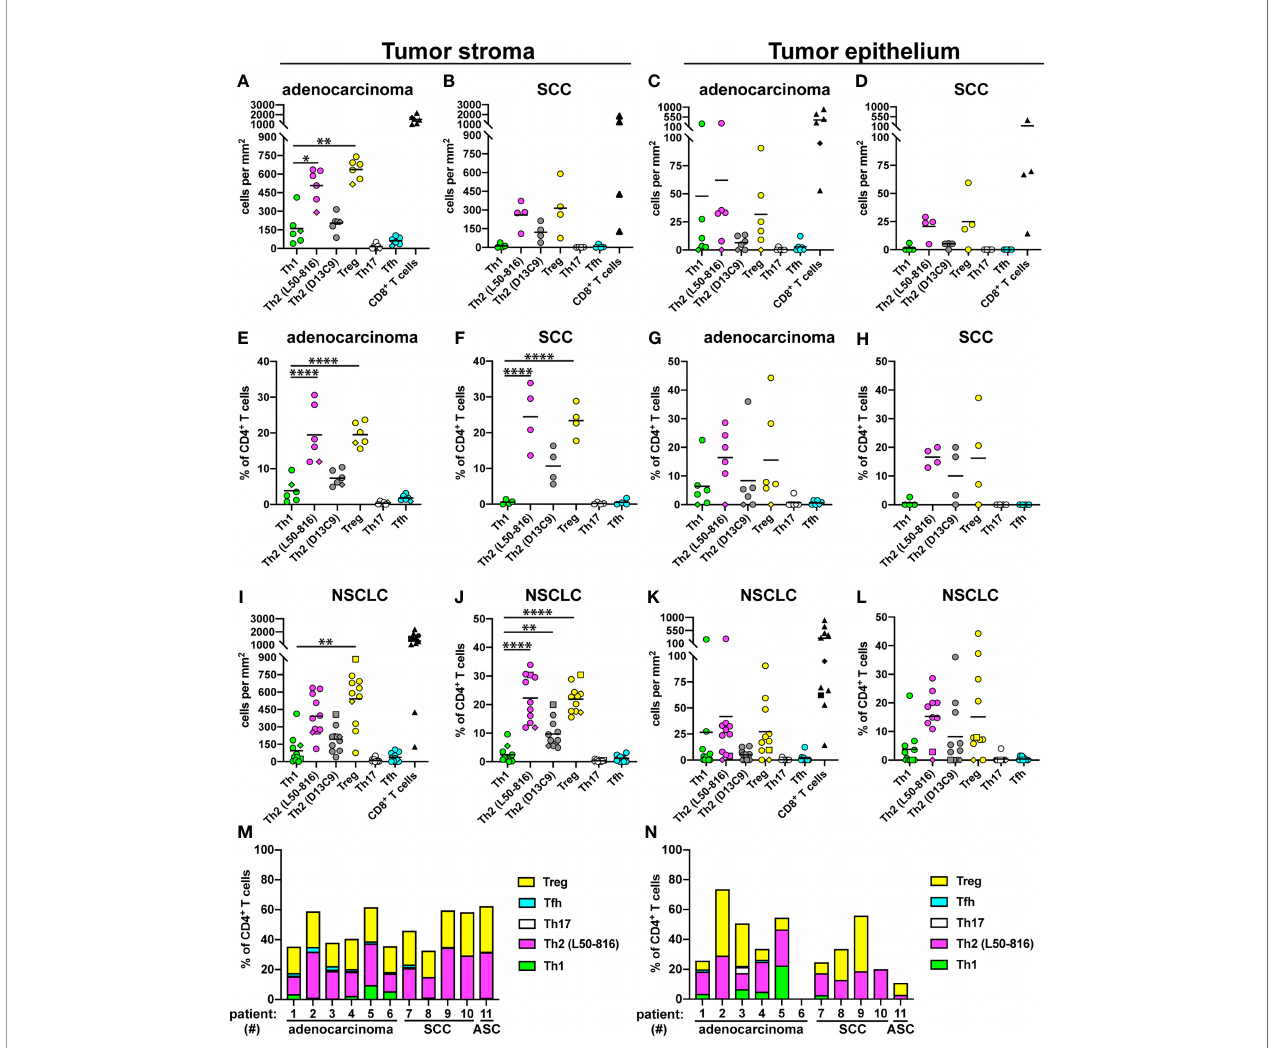
FIGURE 3 | Quanti fi cation of Th subsets and CD8 + T cells in tumor stroma and epithelium. Tumors from 11 NSCLC patients [6 adenocarcinoma, 4 squamous cell carcinoma (SCC), and 1 adenosquamous carcinoma (ASC)] were immunostained as shown in the previous fi gures, and cells were quanti fi ed. Each symbol in the graphs represents one patient and black lines indicate mean values. The rhombus symbol ( ♦ ) indicates the only never-smoker patient. (A) Cell density (number of cells per mm 2 ) in the stroma of adenocarcinoma tumors, or (B) SCC tumors. (C) Cell density in the tumor epithelium of adenocarcinoma, or (D) SCC tumors. (E) Percentage of each Th cell subset (of all CD3 + CD8 - Th cells) in the stroma of adenocarcinoma tumors, or (F) SCC tumors. (G) Percentage of each Th cell subset in the tumor epithelium of adenocarcinoma, or (H) SCC tumors. (I – L) Pooled data for all NSCLC patients. The square symbol indicates the adenosquamous carcinoma patient. (I) Cell density data in tumor stroma. (J) Th percentages in tumor stroma. (K) Cell density data in tumor epithelium. (L) Th percentages in tumor epithelium. (M) Th subset composition (as percent of all CD3 + CD8 - Th cells) for each patient in tumor stroma, or (N) in tumor epithelium. L50-816 and D13C9 indicate two different anti-GATA-3 mAb clones. Statistical analysis was performed using one-way ANOVA with Bonferroni´s post-hoc test. *p<0.05, **p<0.01,